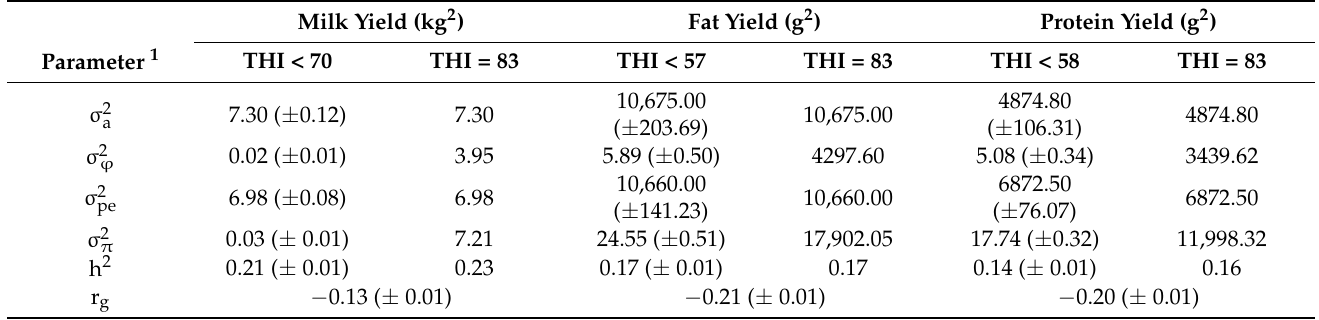
1 σ 2 σ 2 ϕ : additive genetic variance for heat tolerance; σ 2 a : general additive genetic variance; environmental variance; σ 2 π : permanent environmental variance for heat